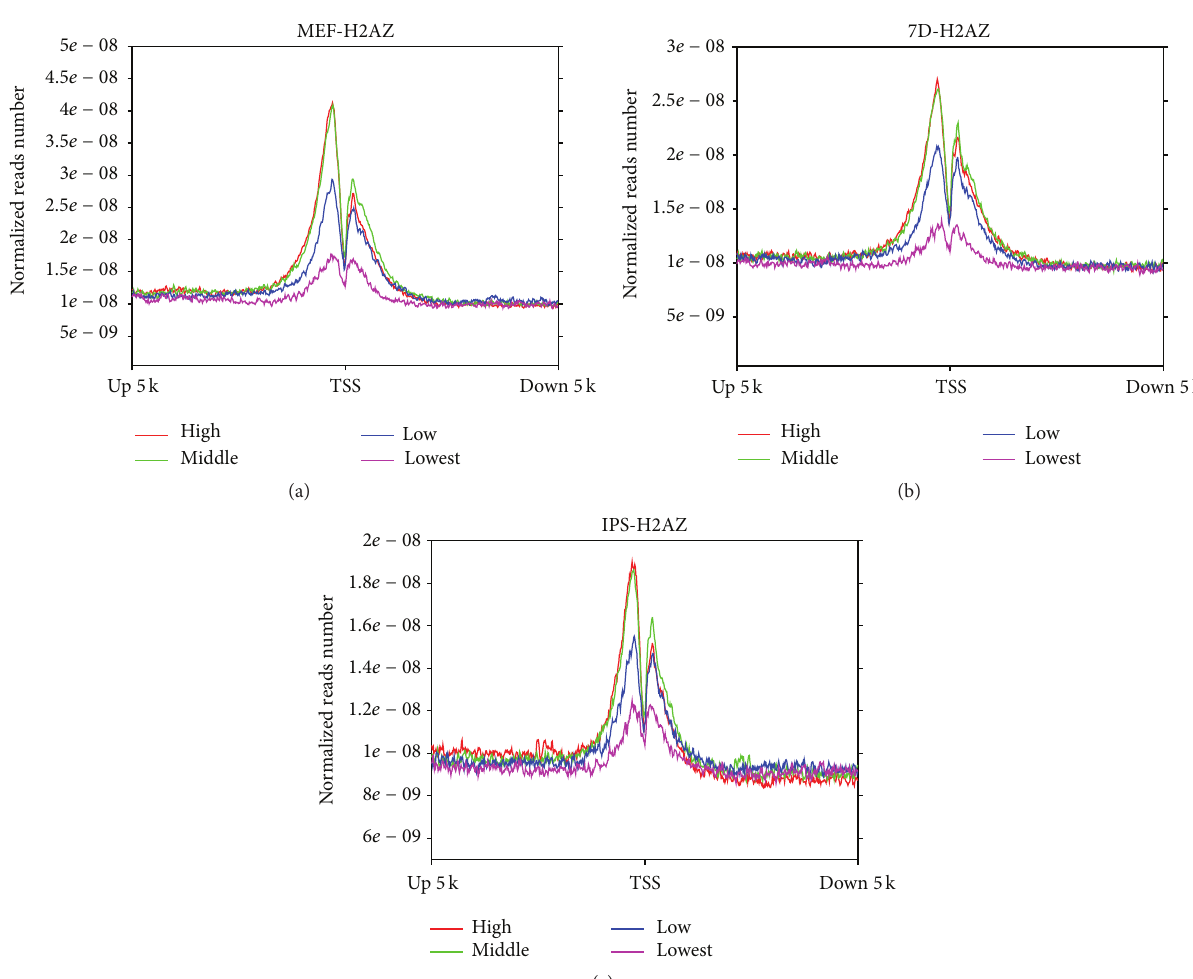
Figure 3: Comparison of microarray expression data and enrichment of H2A.Z in MEFs, Day 7 cells, and iPSCs. Genes are aligned at the TSS and divided into four parts (high, middle, low, and lowest) by decreasing expression level. Statistical H2A.Z normalized reads number in MEFs (a), Day 7 cells (b), and iPSCs (c).